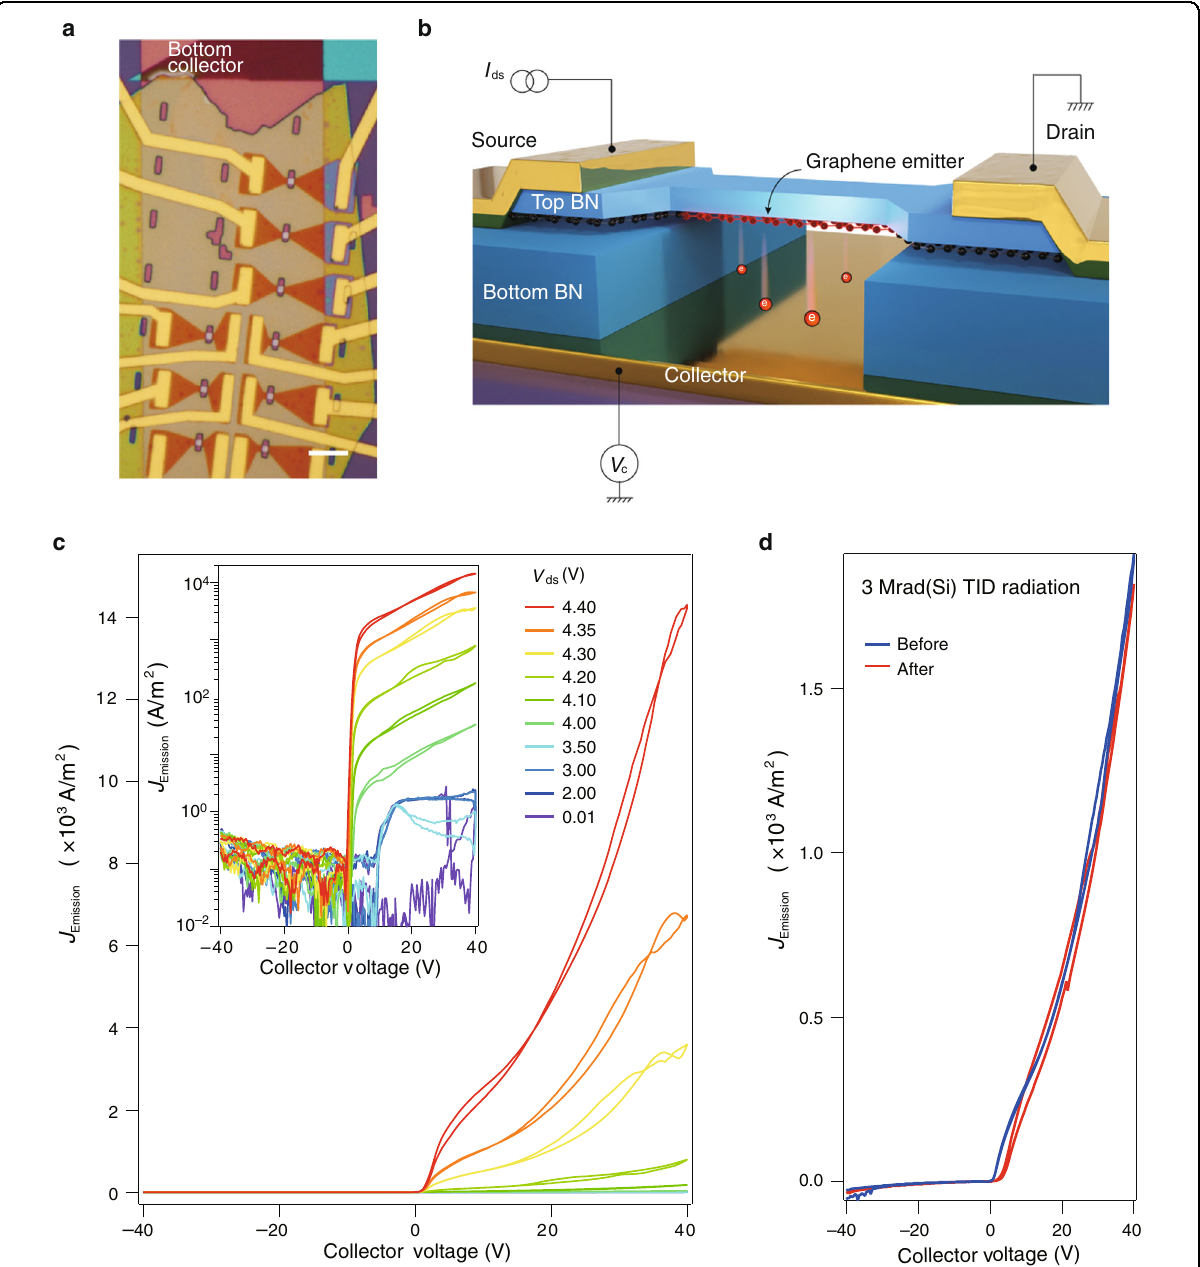
Fig. 3 Thermionic emission diode behavior in h-BN/graphene NOEMS. a Optical micrograph image of the arrays of nanosized vdW NOEMS. Scale bar = 5 μ m. b Art view of the architecture of the “ vintage ” vacuum diode made of vdW heterostructure. c Thermionic emission current density J Emission – V Collector curves in a V Collector range of ±40 V recorded in a typical device. The same data are plotted in a log scale in the inset. Traces and retraces are recorded. Data were obtained at 300 K in a vacuum chamber of about 10 − 2 mbar. d TID radiation effects characterization of the emission current in a typical vdW thermionic emission diode device shown in ( a